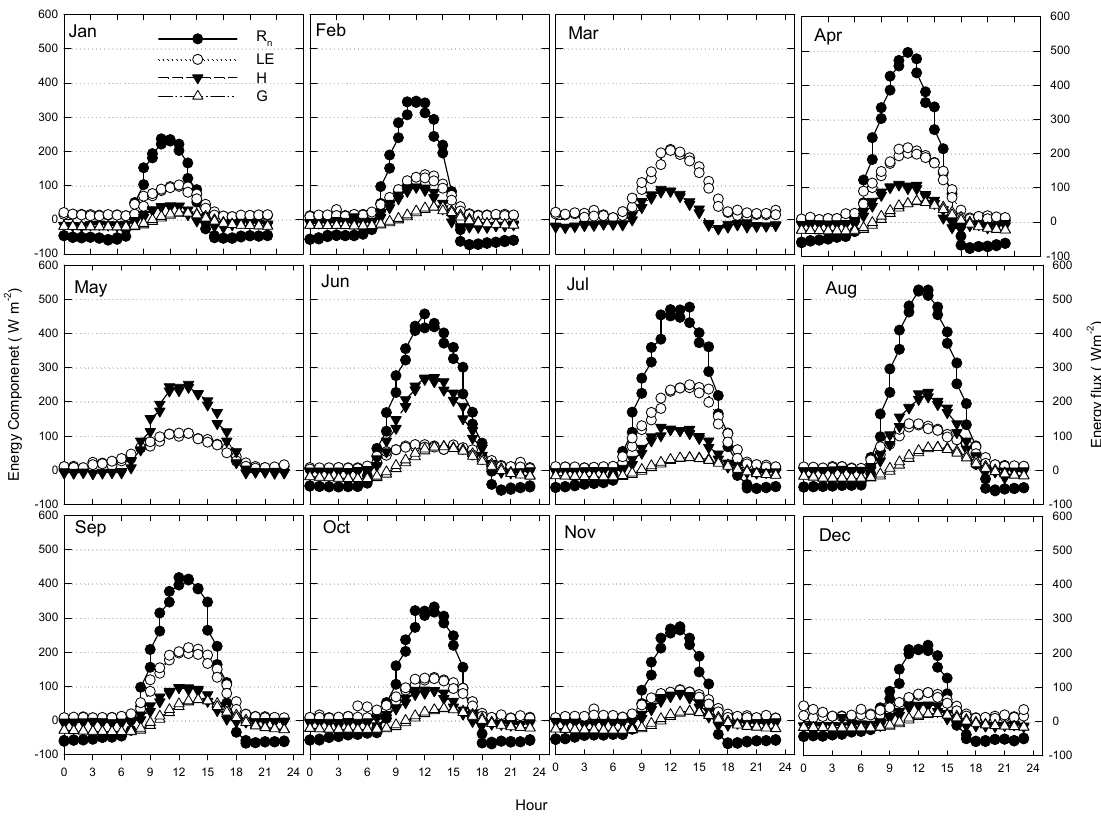
Figure 2. Mean monthly diurnal course of individual components of net radiation ( R n ), latent ( LE ), sensible ( H ), and ground ( G ) heat fluxes in 2007.